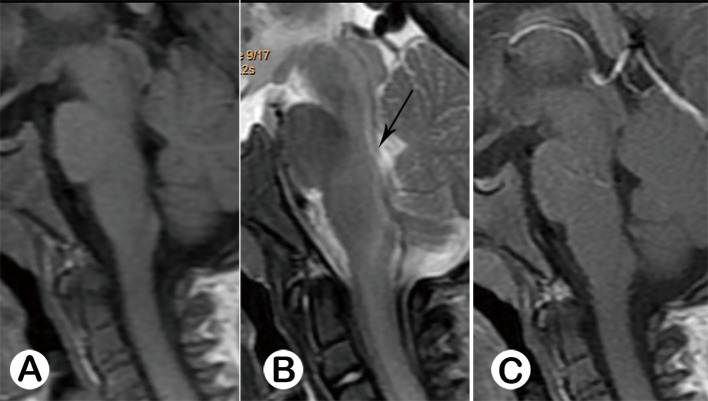
Acute stage type V, Male, 28 months old, on the 11th day of the disease.Whole brain stem was involved in this case, from midbrain to medullar oblongata, demonstrating as prolonged T1 (A) and prolong T2 signal (B, black arrow), without enhancement (C). This subject was hospitalized in PICU for 20 days, and final discharged. Follow-up study showed that there were neurologic sequealae, presenting as irregular breath and extremities tremor during sleeping.